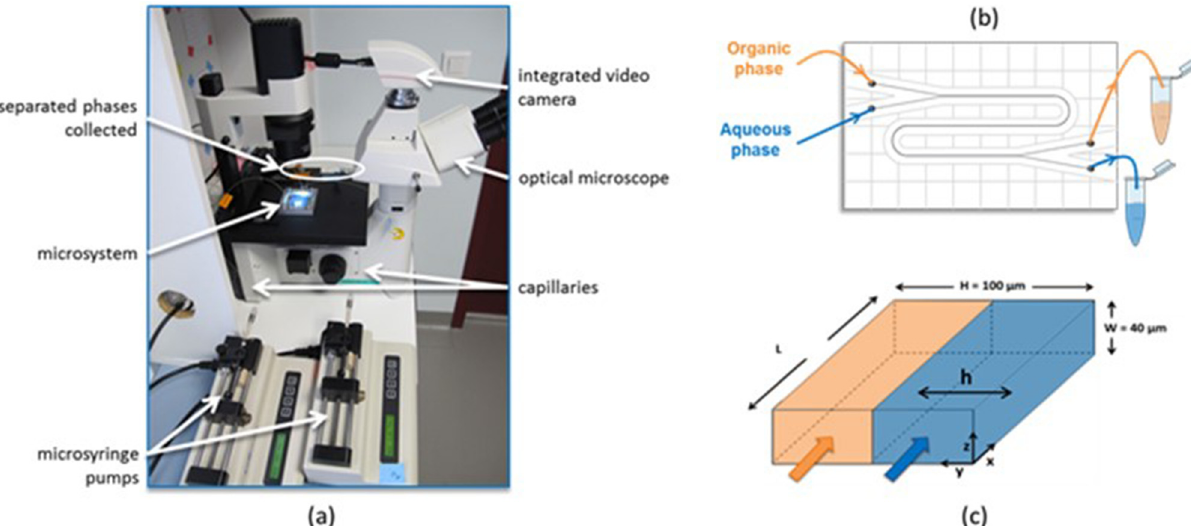
Fig. 1. (a) Experimental setup for extraction studies in a glass microsystem; (b) scheme of the single-stage microsystem; (c) focus on a part of the microchannel: extraction length L = 12 or 20 cm, width H =100 m m, h the position of the interface and depth W =40 m m).